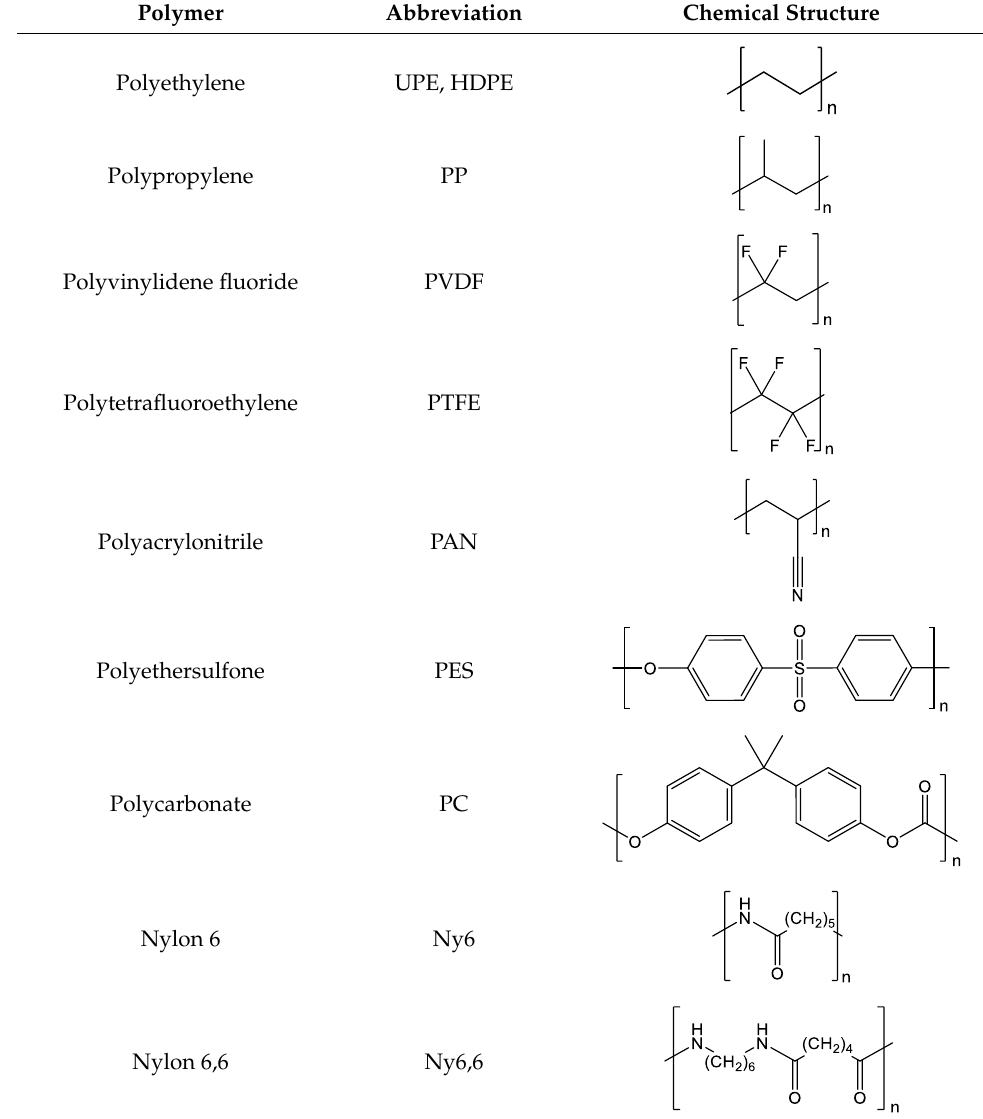
Table 1. Fossil-derived common polymers for usual water filtration membranes.